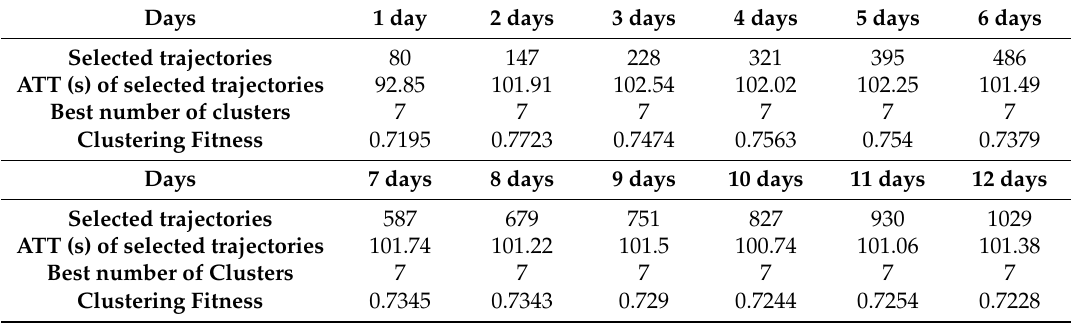
Table 6. Summary of trajectory clustering by increasing number of data collection